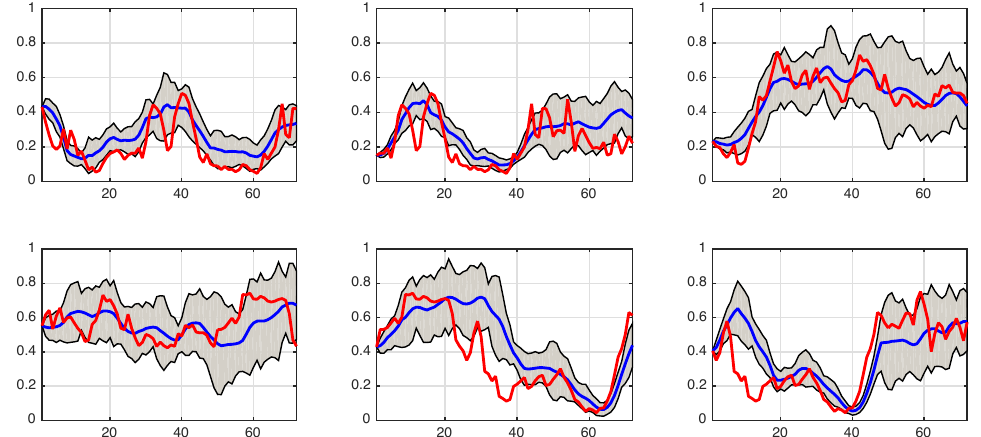
Figure 12. Hybrid bands for six random days in the test-set [blue is the centroid, the red one is the actual